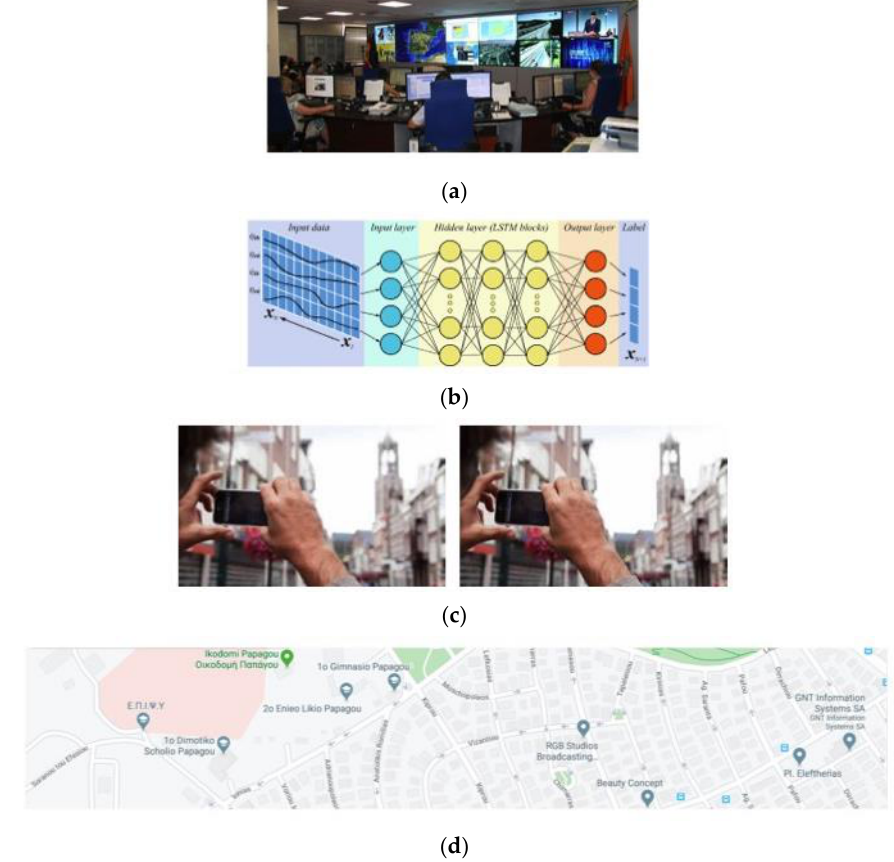
Figure 1. Overview of the four layers of the proposed system. ( a ) Municipality headquarters layer; ( b ) inference engine model layer; ( c ) smartphone crowdsensing layer; and ( d ) environmental crowdsourcing municipality layer.